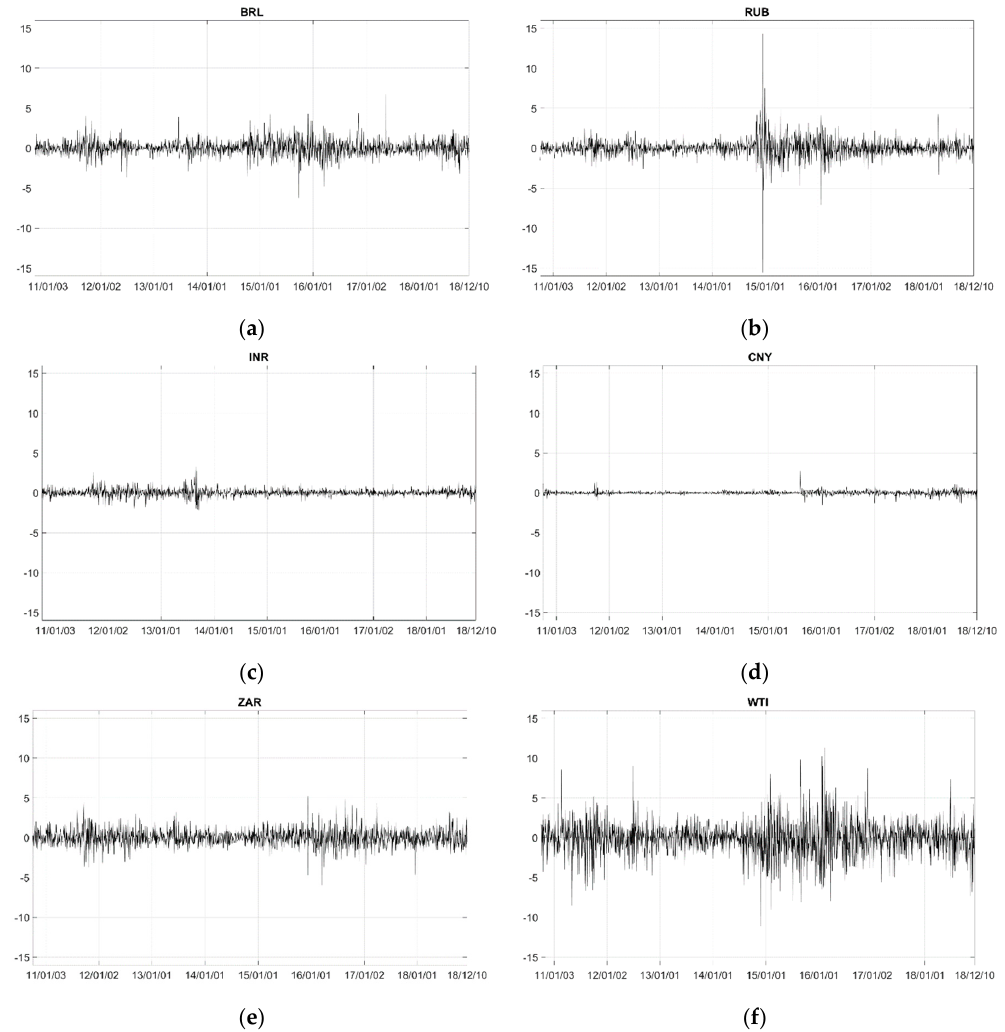
Figure 1. Daily returns on the exchange rates and crude oil prices. ( a – f ) refer to return series of BRL, RUB, INR, CNY, INR and WTI, respectively. Table 4. Summary statistics .